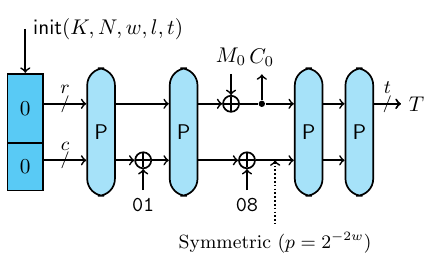
Figure 5: Forgery second step: attempt forgery with rotated ciphertext and